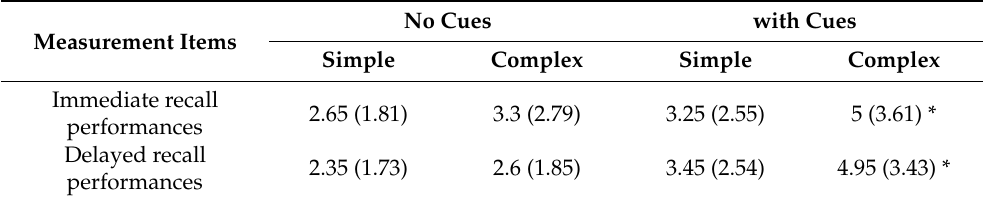
Table 2. Means and (standard deviations) of immediate and delayed recall performances as a function of all experimental